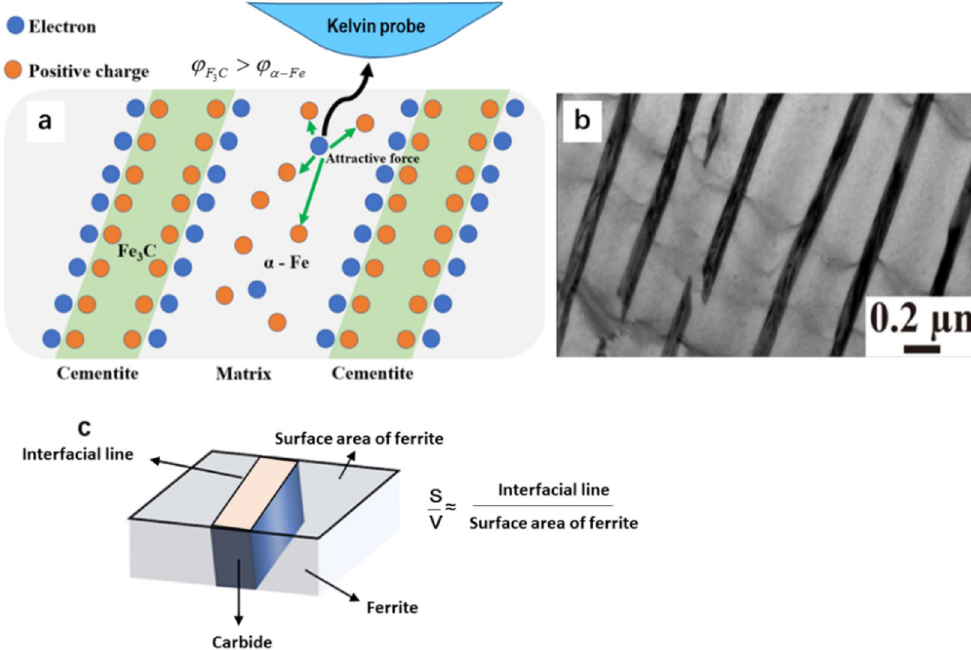
Figure 5. ( a ) Schematic of the charge-compensation model: electrons move towards the Fe/Fe 3 C interface, building a dipole layer to stop further charge accumulation. The ferrite region becomes electron-depleted, ( b ) A TEM image of pearlite consisting ferrite and cementite (dark), ( c ) 3D schematic of